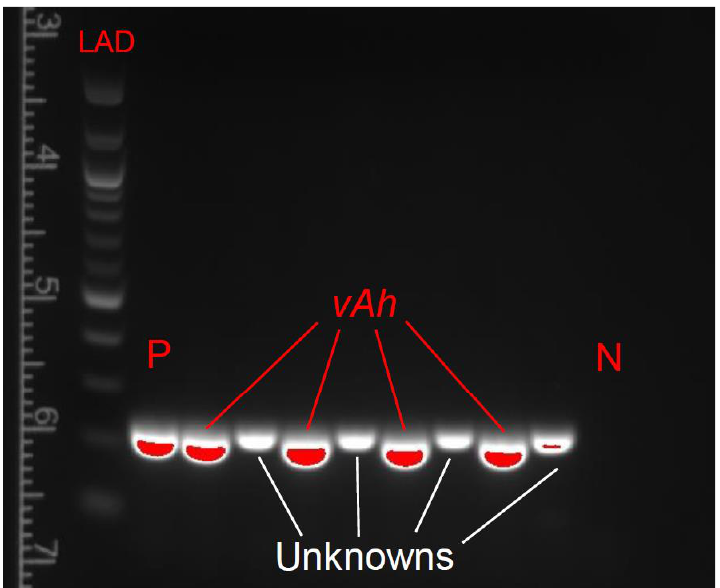
Figure 3. PCR product banding of virulent Aeromonas hydrophilia (vAh) and unknown bacterial iso- lates collected from pilot trial day 41. Positive and negative controls and the DNA ladder were labeled as P, N, and LAD, respectively. Agarose gel (2%) image visualized on an ultraviolet transillumination after. Isolates of vAh formed product bands at 246 bp.